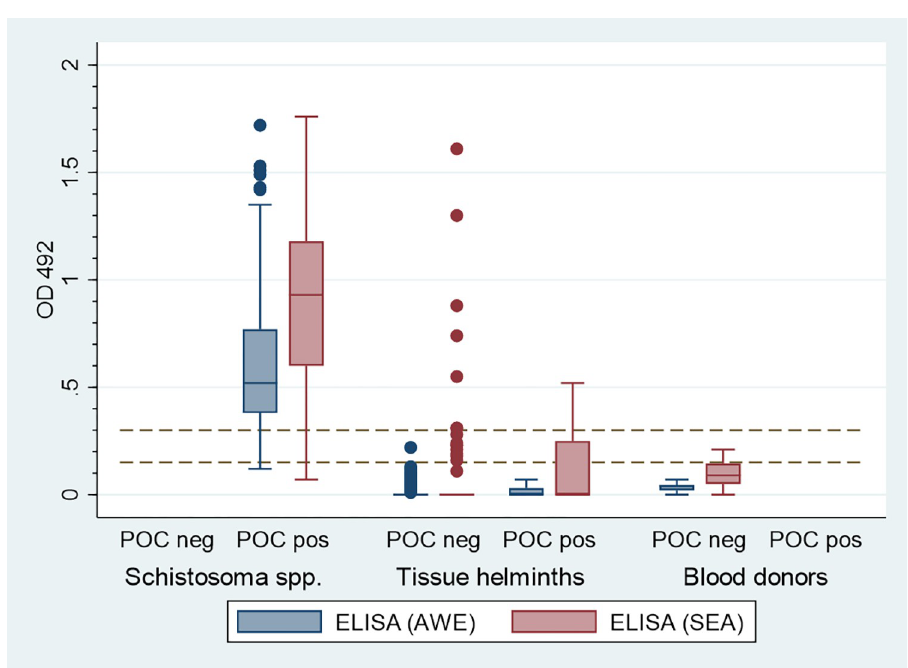
Fig 1. Schistosoma spp. (n = 74), tissue helminth (n = 80) and blood donor (n = 20) sera. OD 492 values of Adult antigen ELISA (AWE) and egg antigen ELISA (SEA) plotted for serum panels with ICT IgG-IgM POC negative and positive results. ELISA (AWE) OD < 0.15 negative, OD 0.15–0.29 inconclusive, OD � 0.3 positive. ELISA (SEA) OD < 0.3 negative, OD 0.3–0.59 inconclusive, OD � 0.6 positive. Dotted lines show the two cutoff values of the